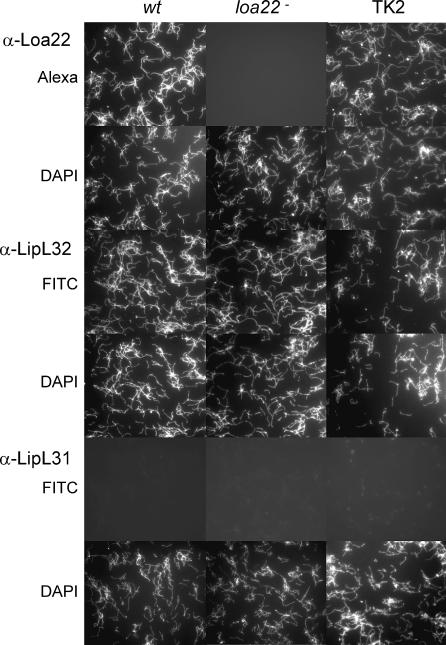
Surface Localization of Loa22Surface immunofluorescence assay was performed with L. interrogans wild-type strain (wt), mutant loa22− (loa22−), and mutant loa22− complemented with wild-type loa22 (TK2). Strains were labeled with antibodies against Loa22 and the following lipoproteins: LipL32, a surface-exposed lipoprotein [20], and LipL31, a lipoprotein that is associated with the inner membrane and not surface-exposed [20]. Alexa and fluorescein isothiocyanate (FITC)–conjugated secondary antibodies were used to detect surface-bound antibodies to Loa22 and LipL32 and LipL31, respectively. A DAPI counterstain was used to document the presence of leptospires. A photomicrograph is shown from one of three representative experiments.